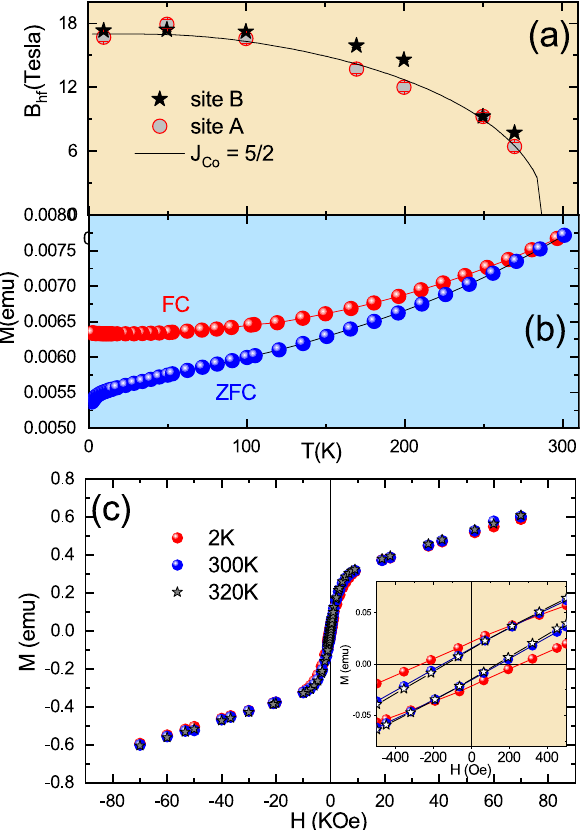
111 Cd for sample up to room temperature. ( b )